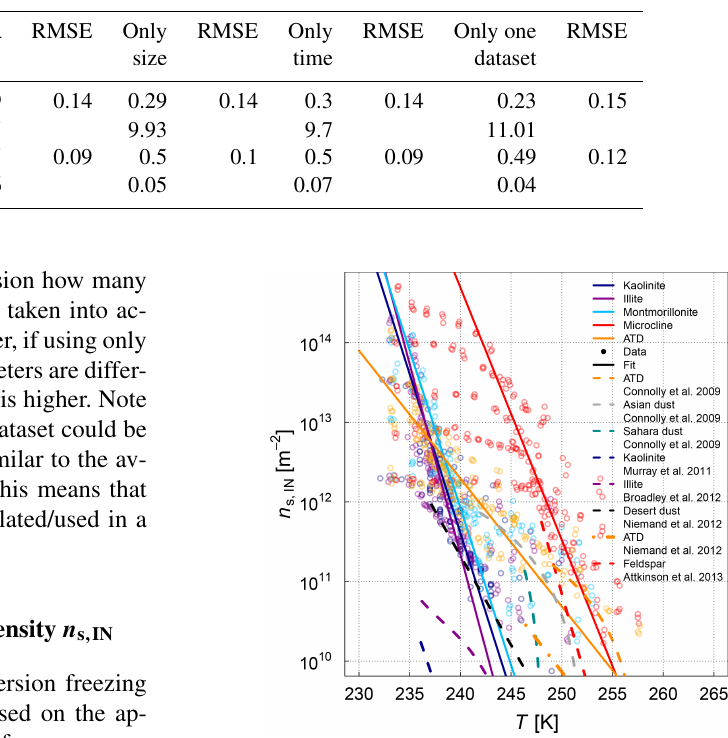
Figure D1. Surface site density n s , IN of different mineral dust types. The points are calculated surface site densities from FF mea- surements, and the lines are the corresponding fits. The fits are based on FF (Eqs. D3 and D6 (method 1); Table D1, fifth row). Some es- timates of n s , IN found in literature are added. Colors indicate the dust type, and the line type indicates different literature